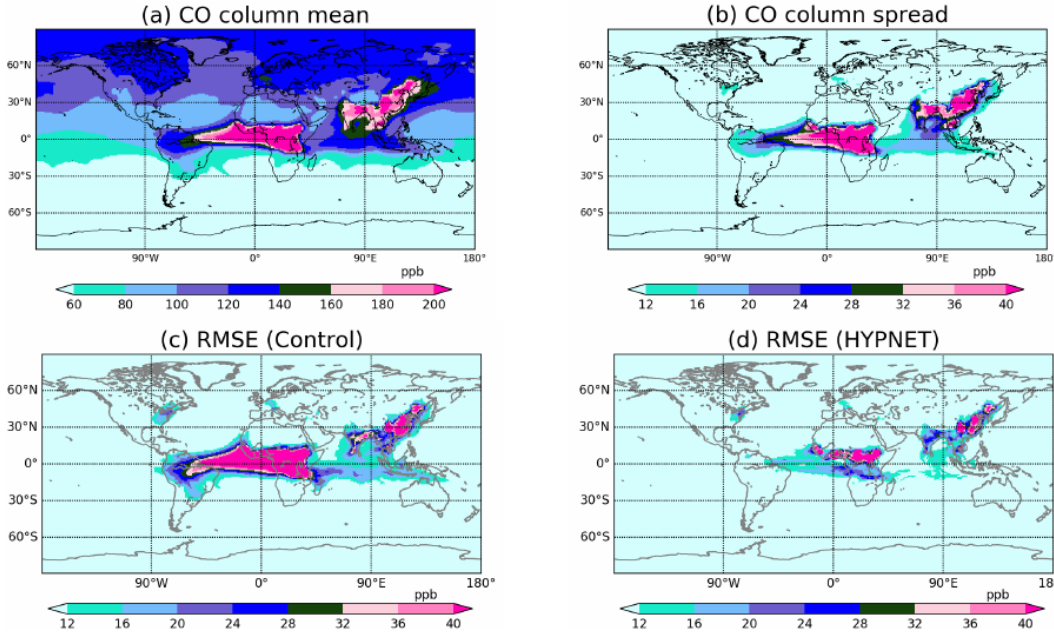
Figure 6. In each panel, column means (0–5km) averaged from 10 January 2015 at 18:00:00UTC to 28 February 2015 at 00:00:00UTC are shown: (a) CO ensemble mean of the control experiment; (b) CO ensemble spread of the control experiment; (c) RMSE of the control experiment; and (d) RMSE of the EXP_HYP experiment.